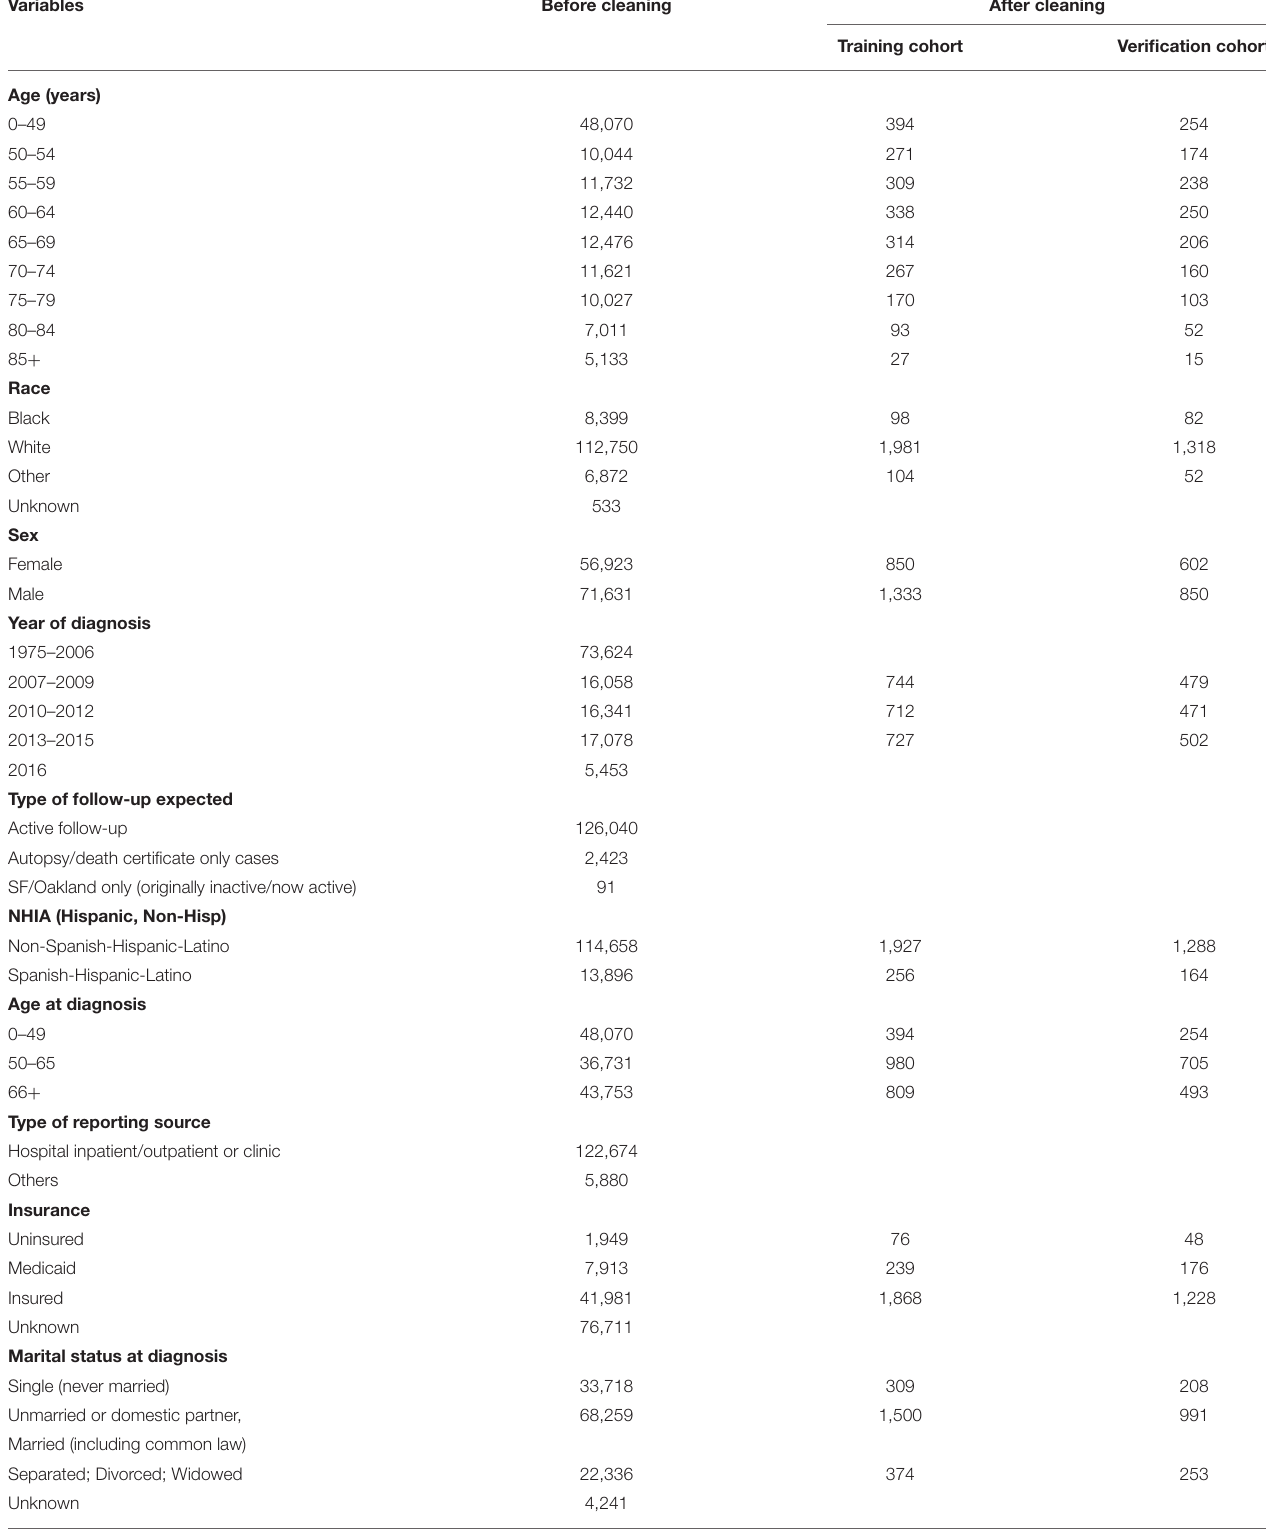
TABLE 1 | Cleaning of patient demographic